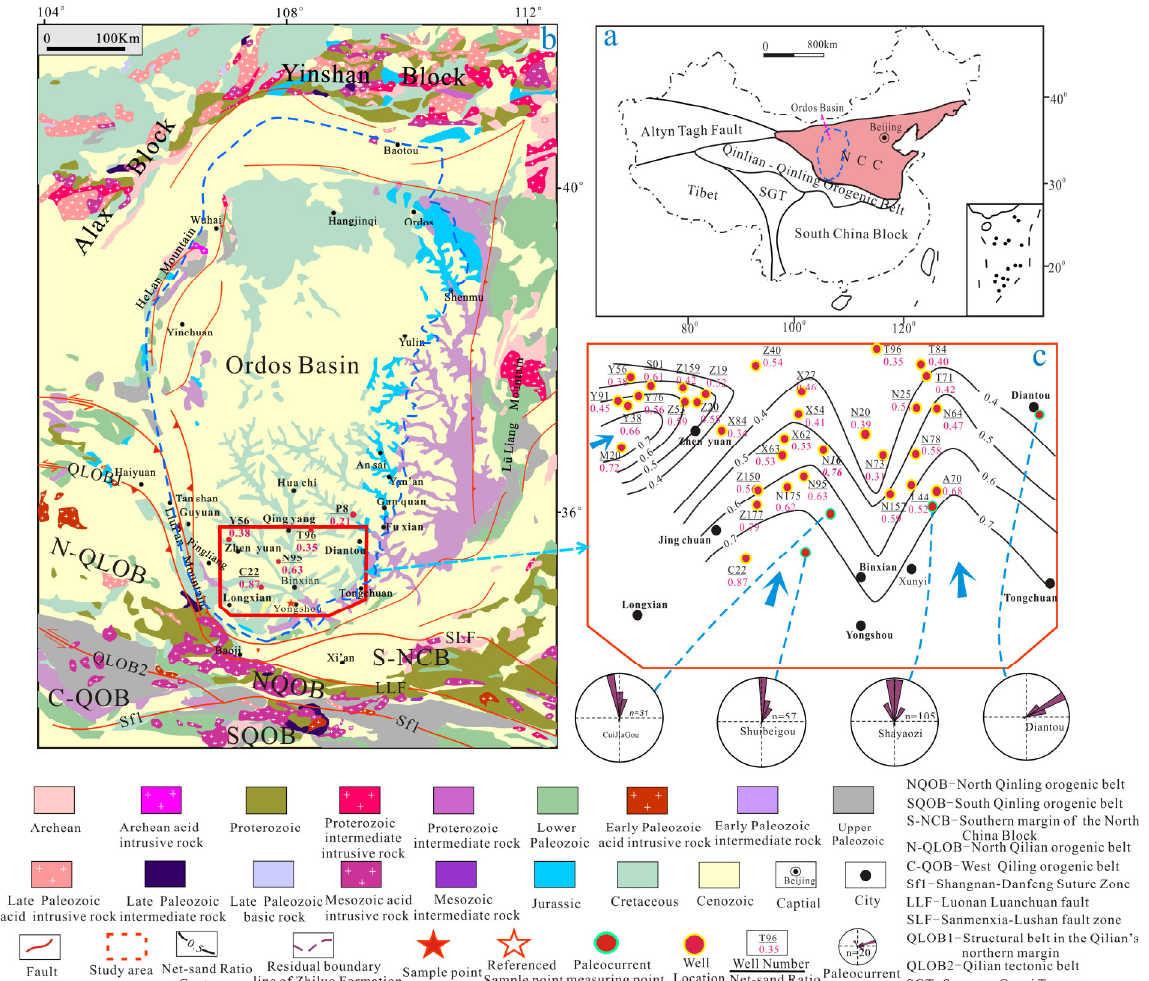
Figure 1. ( a ) Tectonic framework of China, showing the location of the NCC; ( b ) Schematic diagram of the regional tectonic location in the study area and periphery of the Ordos basin; ( c ) Net-sand ratio map and Paleocurrent directions of the Zhiluo Formation in the study area. (( a , b ) are modified after [39,40]).